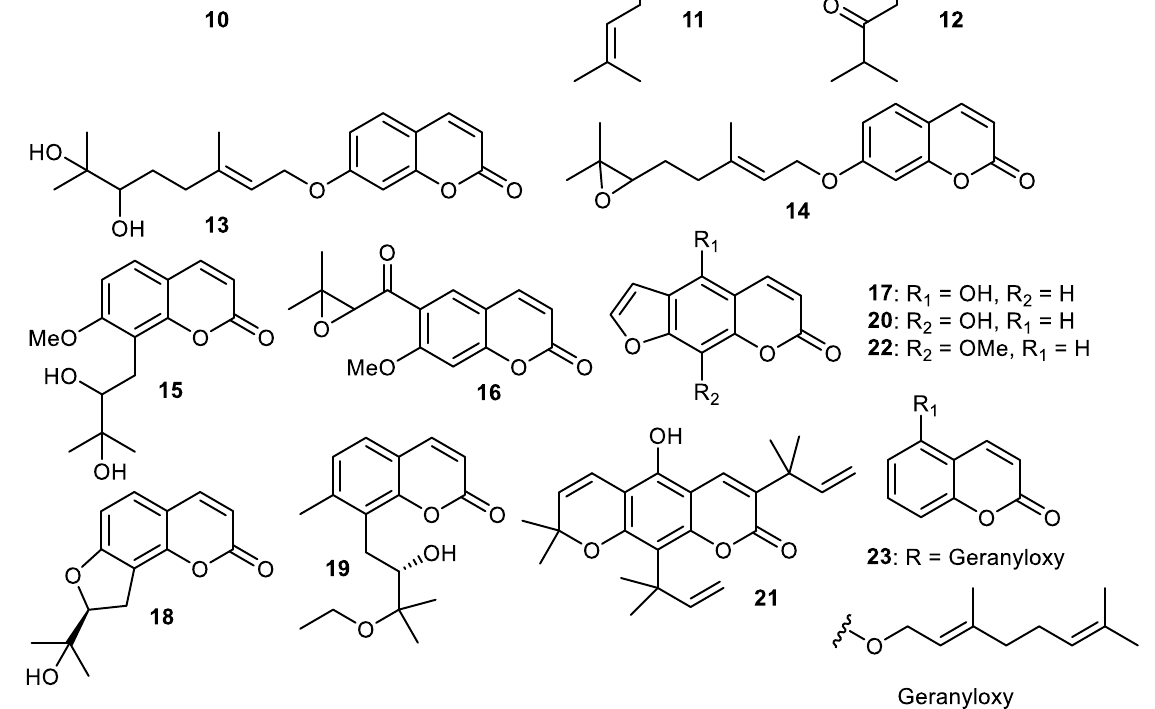
Figure 2. Structures of coumarins 10 – 23 .